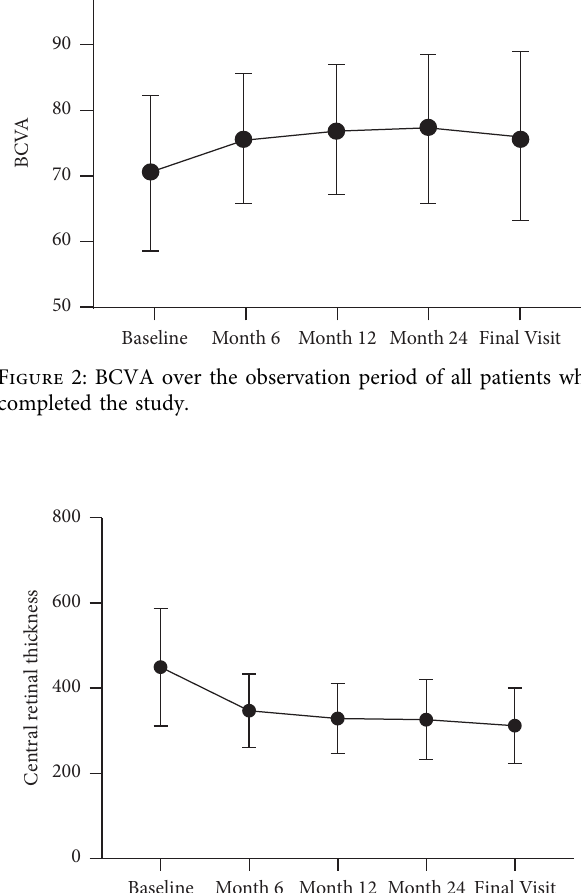
Figure 3: CRT over the observation period of all patients who completed the study.